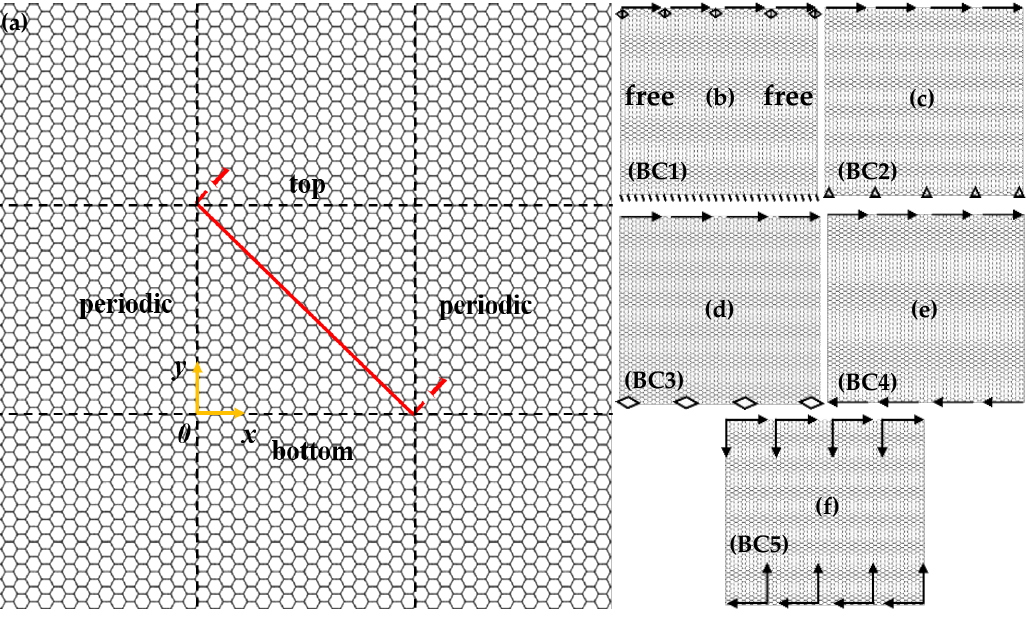
Figure 1. ( a ) The periodic image of the single-layered graphene sheets (SLGS) model, and ( b – f ) SLGS with five forms of boundary conditions. Table 1. The degree of freedoms (DOFs) under five boundary conditions. (U x , U y and U z represent the DOFs along the x, y , and z directions, respectively.).